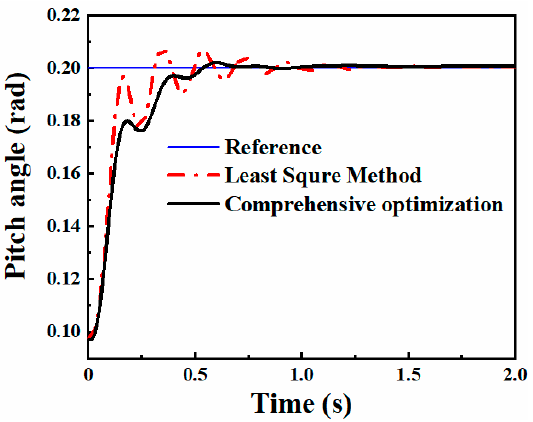
Figure 20. Block diagram of the stability control system.